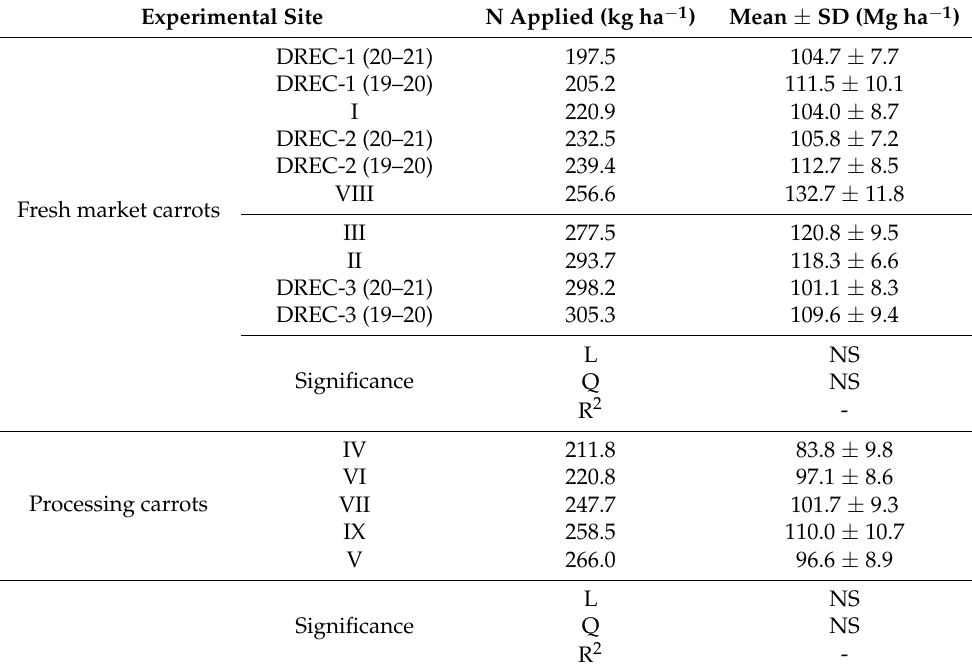
Table 7. Mean fresh storage root yields ( ± standard deviation) at the experimental